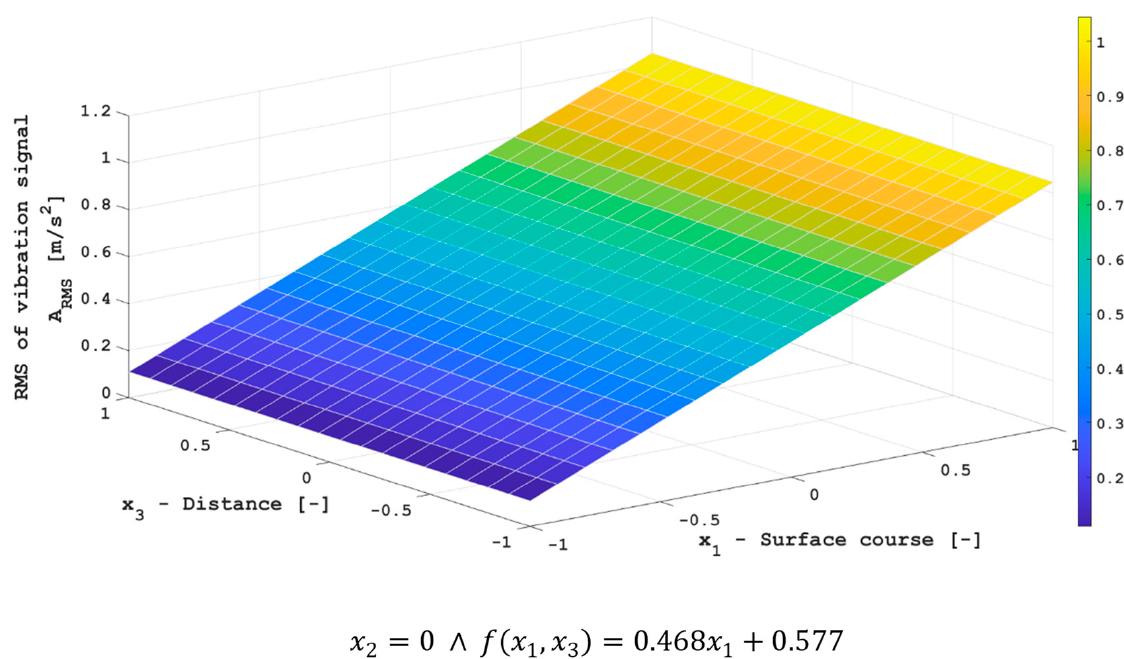
Figure 7. A RMS signal values, depending on the surface course and the distance traveled, when moving an electric scooter at a speed of 15 km/h.